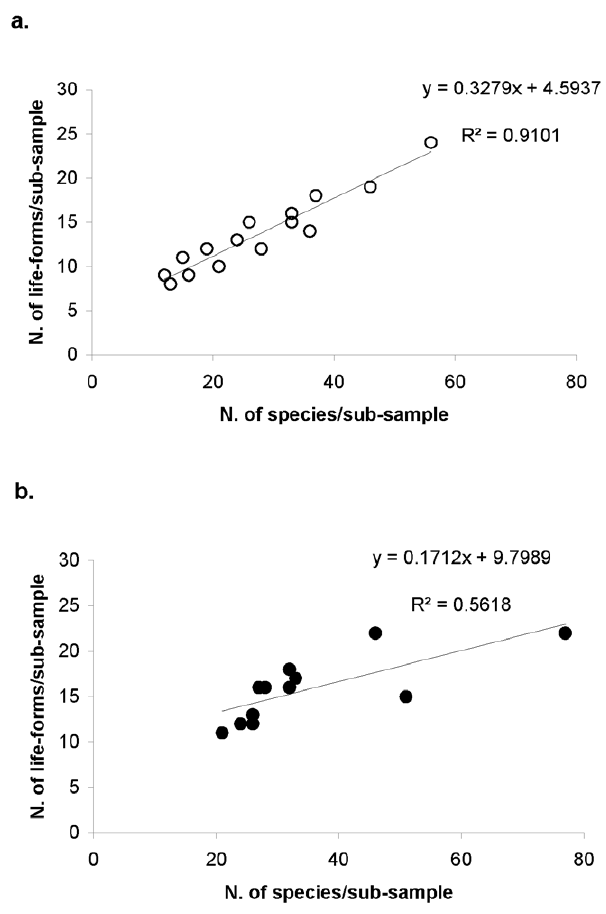
Figure 4. Relationship between functional diversity and species richness within the nematodes communities. (a) control and (b) sponge samples (sediment-depth 0–1 cm). R 2 for a linear relationship. Results of regression: a. no. of cases: 15; p , 0.001; df=1.13; b. no. of cases: 12; p=0.005; df=1.10. doi:10.1371/journal.pone.0029152.g004 PLoS ONE |